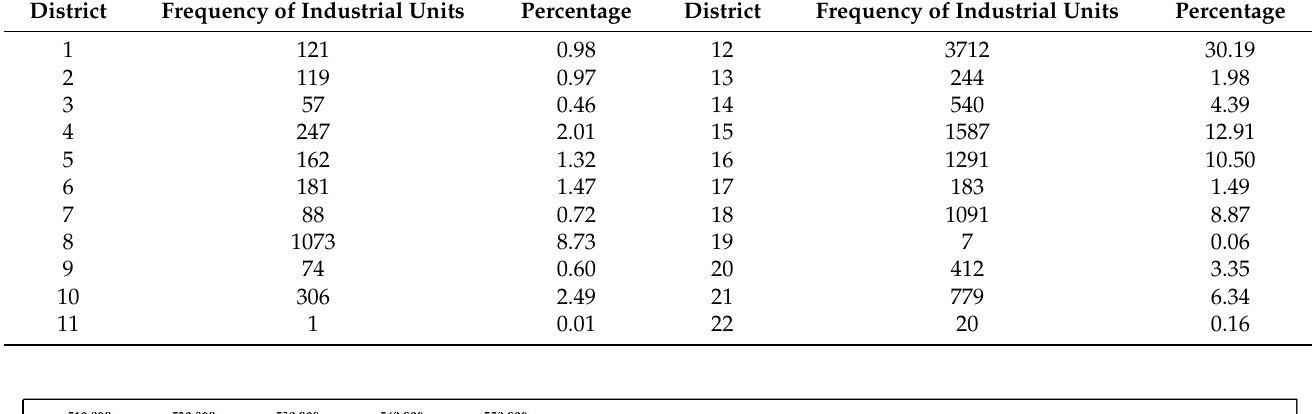
Table 7. Frequency and percentage of industrial units in Tehran municipality district.